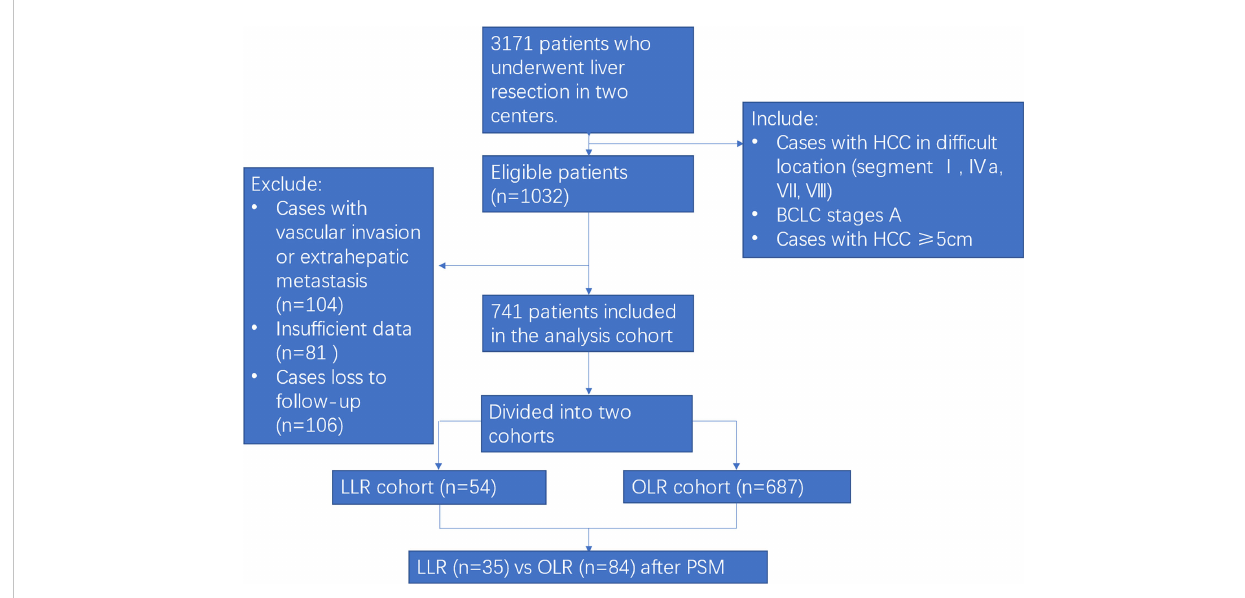
FIGURE 1 Flow chart of the study. HCC, hepatocellular carcinoma; PSM, propensity score matching; LLR, laparoscopic liver resection; OLR, open liver resection.